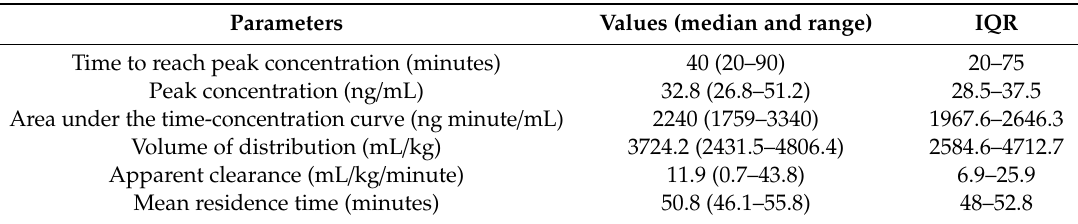
Table 2. Pharmacokinetic parameters.